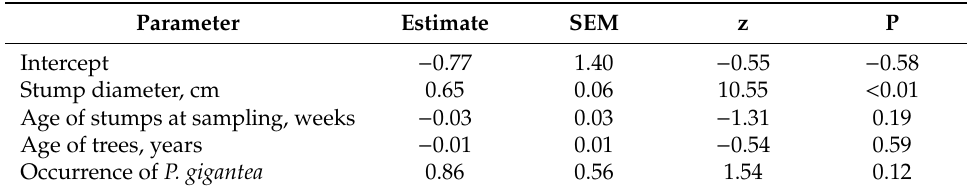
Table 3. Regression analysis summary for individual effects of parameters on occurrence of Heterobasidion . r 2 = 0.20; SEM, standard error of the mean.